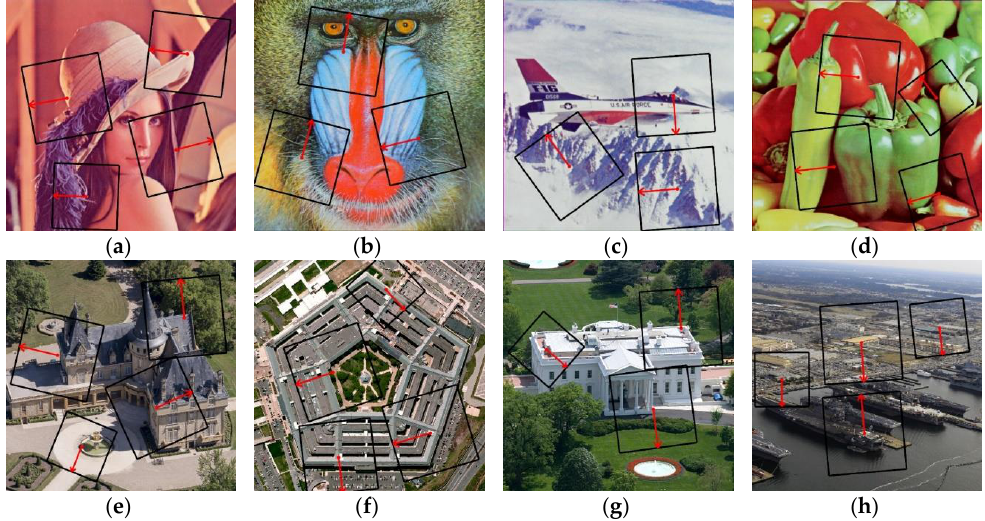
Figure 5. The selected local square feature regions (LSFRs) for watermark embedding of eight host images.